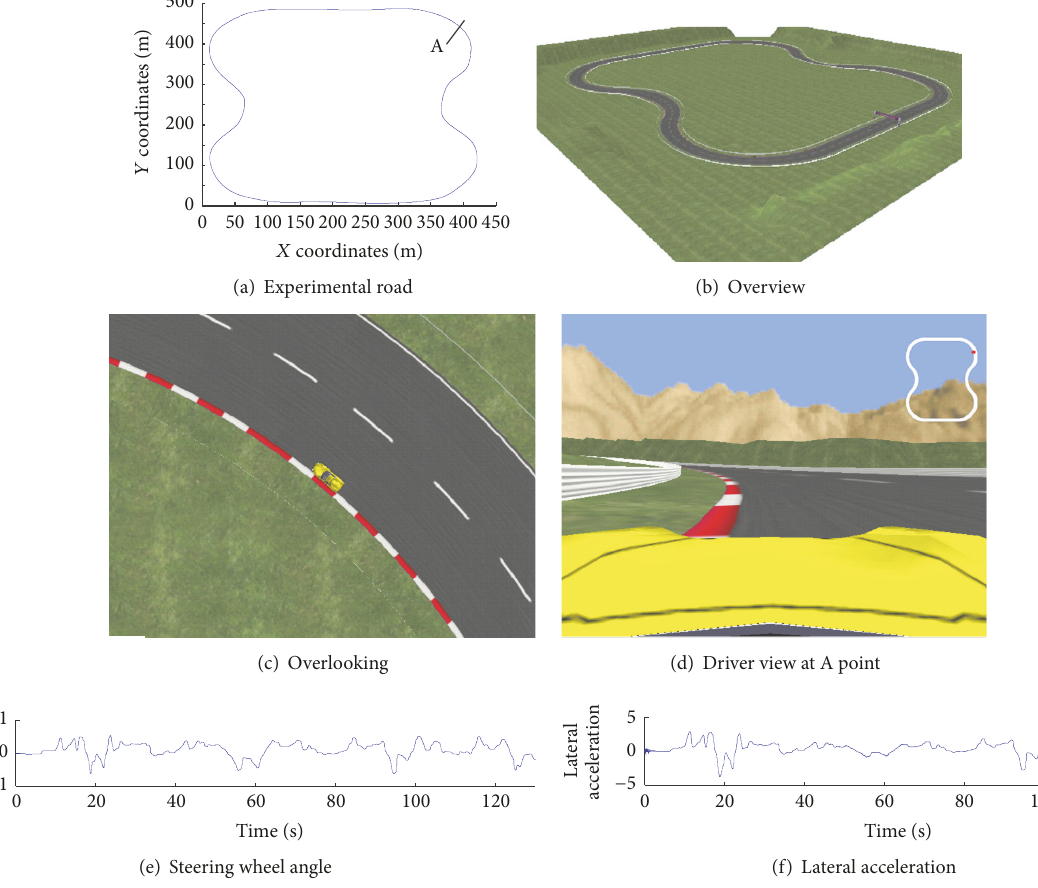
Figure 6: Simulation of the driving path and the driving state of the